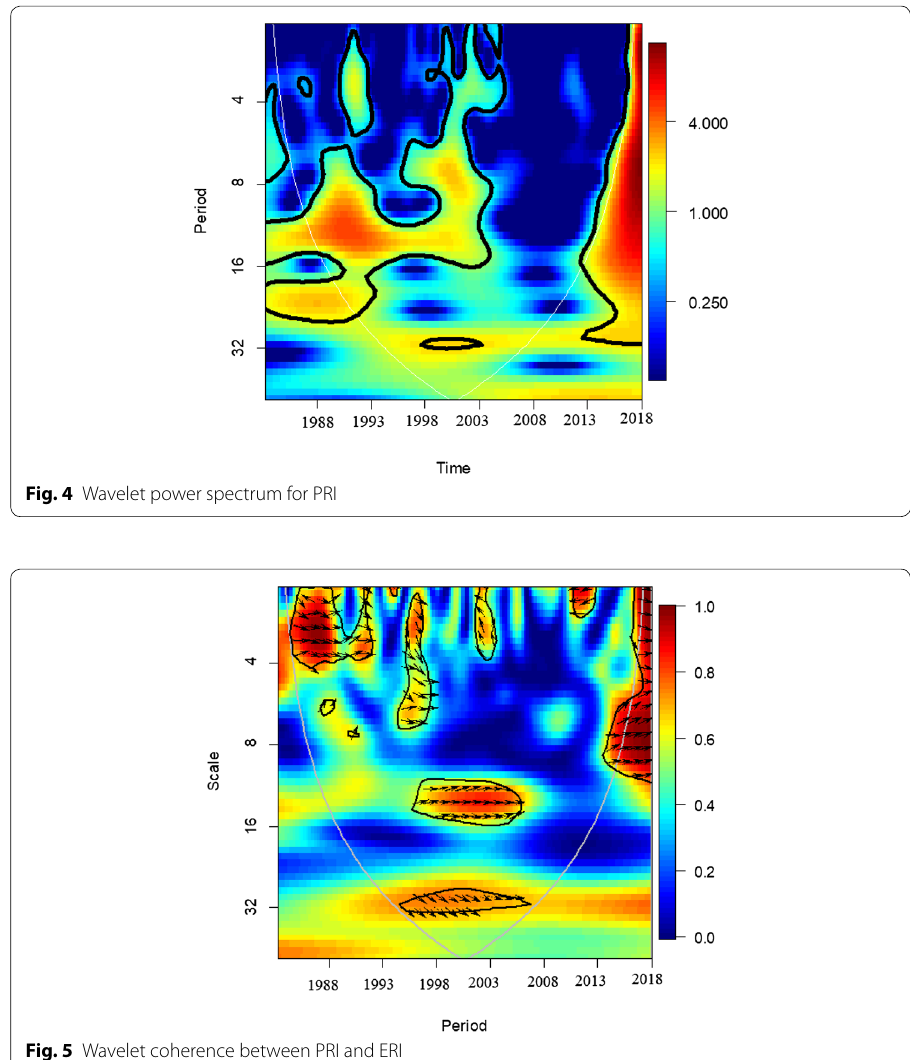
thick black line. While arrows pointing to the left indicate negative correlations among the variables, arrows pointing to the right represent positive correlations. In addition, arrows pointing to the up, right-up or left-down show that the second variable causes the first variable, whereas arrows pointing to the down, right-down or left-up indicate that changes in the first variable significantly lead to changes in the second variable. With reference to Fig. 5, as the arrows are pointing rightward and downright between 1998 and 2008 at different frequency levels, this indicates that economic risk and politi- cal risk are in phase. Moreover, as those arrows are pointing downright between 1994 and 2008 at relatively long-term scales (low frequencies), meaning that the economic risk index is led by the political risk index, this indicates that political risk is an impor- tant predictor for economic risk in Venezuela. As can be seen in Fig. 6, in the long run (low frequencies), the rightward pointing arrows indicate that changes in political risk in Venezuela lead to changes in financial risk. The main difference among the figures is the